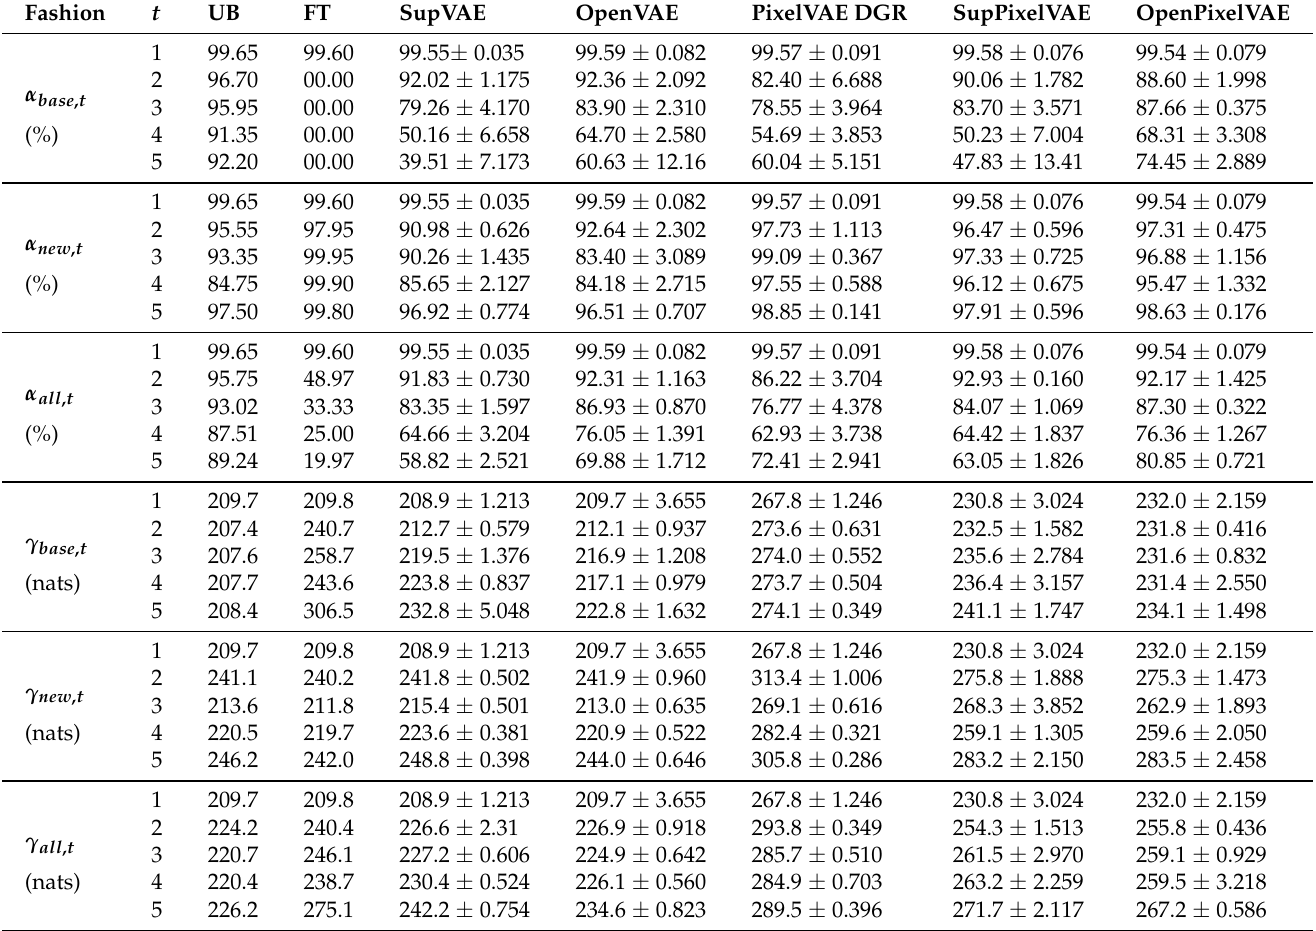
Table A6. The results for class incremental continual-learning approaches averaged over five runs, baselines and the reference isolated learning scenario for FashionMNIST at the end of every task increment. This is an extension of Table 3 in the main body. Here, in addition to the accuracy α t , γ t also indicates the respective NLL at the end of every task increment t